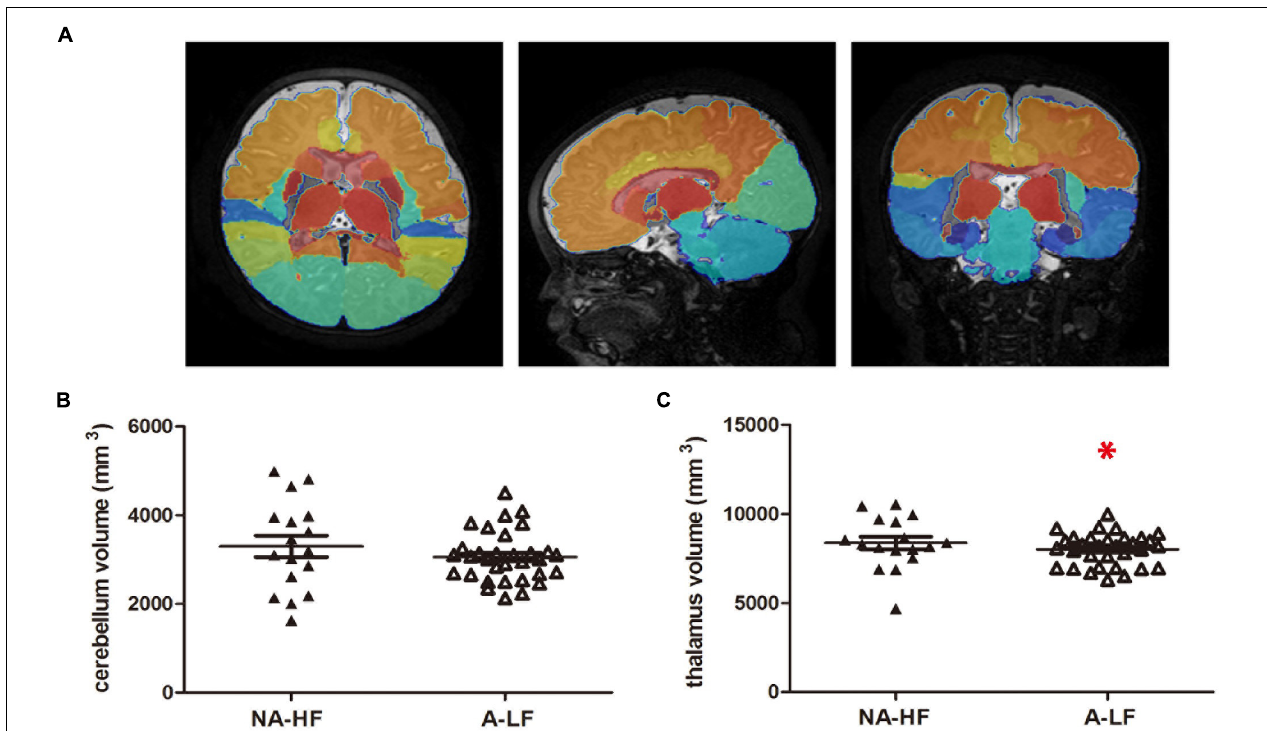
FIGURE 3 | The volumes of motor-related regions. (A) The whole brain of each subject was segmented into 83 brain regions using the atlas of the Developing Brain Region Annotation with Expectation-Maximization. (B) There was no significant difference in the volumes of cerebellum between the A-LF and NA-HF groups. (C) The volume of the thalamus was smaller in the A-LF group than in the NA-HF groups. * p < 0.05.